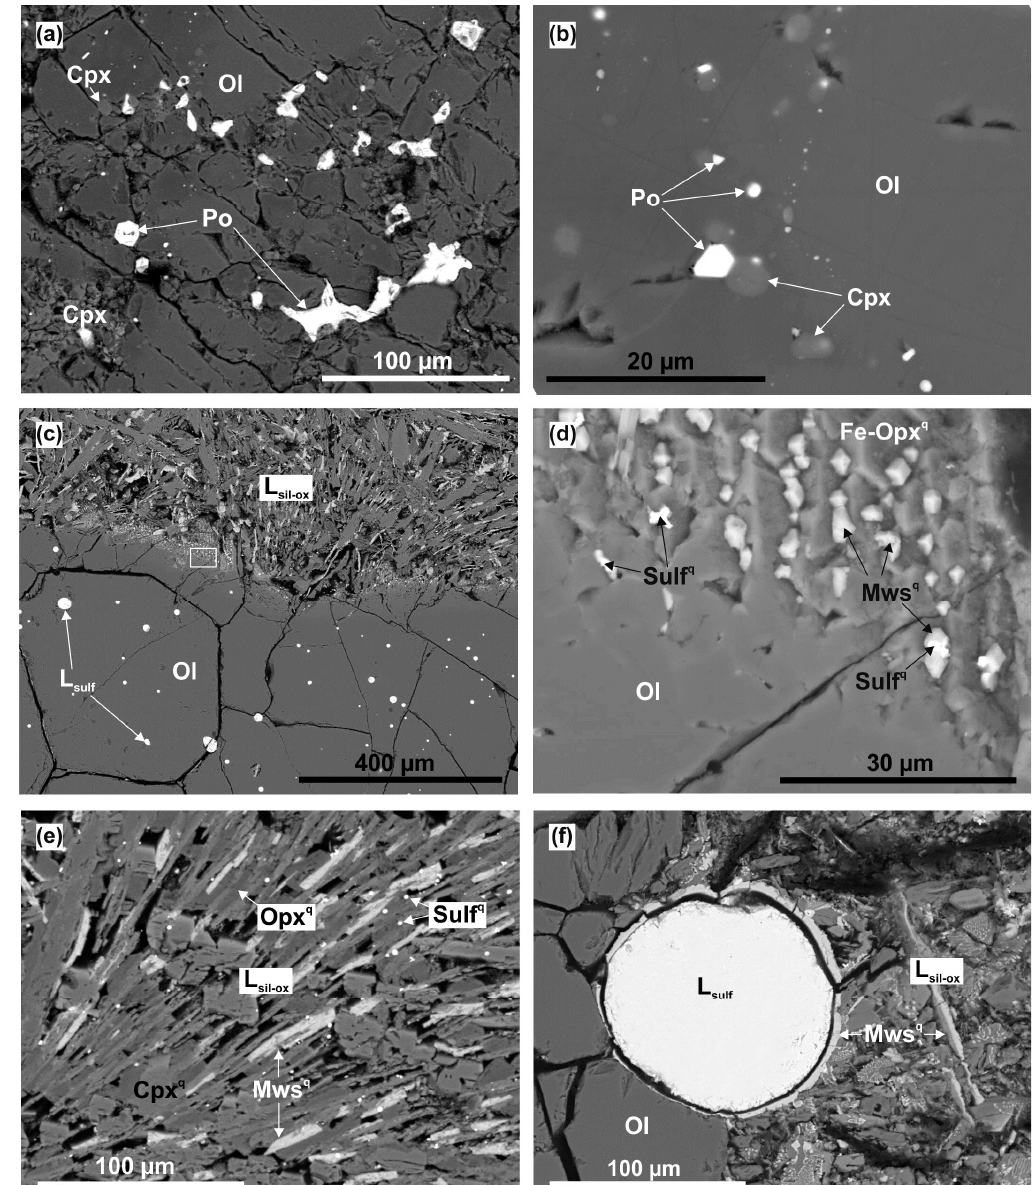
Figure 3. Scanning electron microscopy (SEM) images of polished fragments of the samples after experiments in olivine–anhydrite–C system, ( a – d ) 1050 °C, xS = 2 mol %, ( e – f ) 1450 °C, xS = 2 mol %: ( a ) Polycrystalline aggregate of recrystallized olivine with clinopyroxene and pyrrhotite in interstices; ( b ) inclusions of clinopyroxene and pyrrhotite in recrystallized olivine; ( c ) recrystallized olivine with sulfide melt inclusions, at the contact with the quenched silicate-oxide melt; ( d ) enlarged fragment of Figure 3c, quenched magnesiowüstite and ferrous orthopyroxene at the contact with olivine; ( e ) structure of the quenched silicate-oxide melt, consisted of pyroxenes and magnesiowüstite; ( f ) a contact of the quenched sulfide melt spherule with the quenched silicate-oxide melt, and a rim of magnesiowüstite between them; Ol —olivine, Cpx —clinopyroxene, Po —pyrrhotite, Sulf—sulfide, L sil-ox —silicate-oxide melt, L sulf —sulfide melt, Opx —orthopyroxene, Mws —magnesiowustite, q —quenched phase.